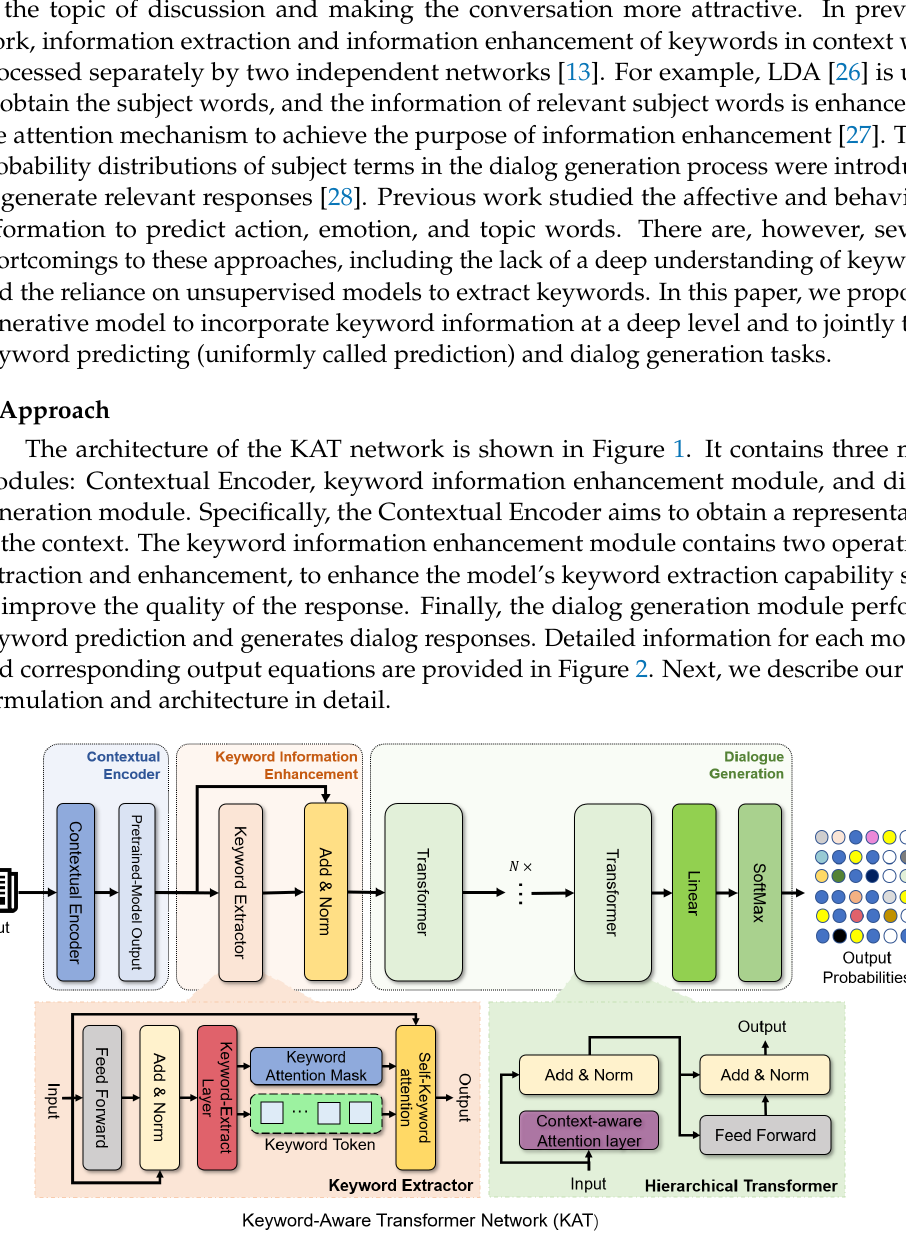
Figure 1. The overview of the proposed Keyword-Aware Transformers Network including Contextual En- coder, keyword information enhancement module, and dialog generation module. The Keyword Extractor is on a salmon background, while the Hierarchical Transformer layer is on a light green